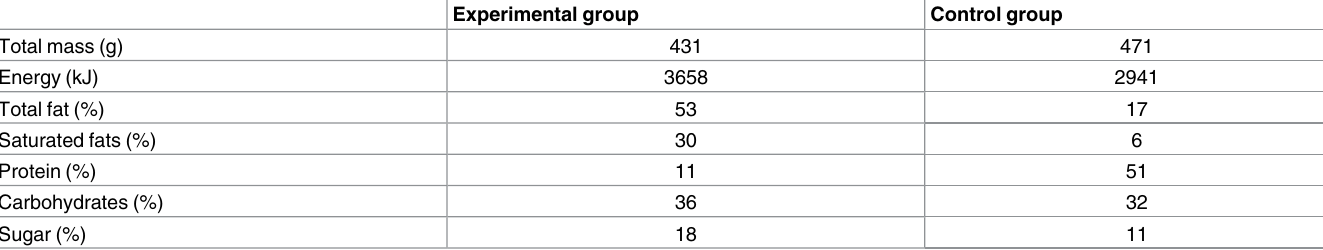
Table 1. Nutritional breakdown of the breakfast by group.